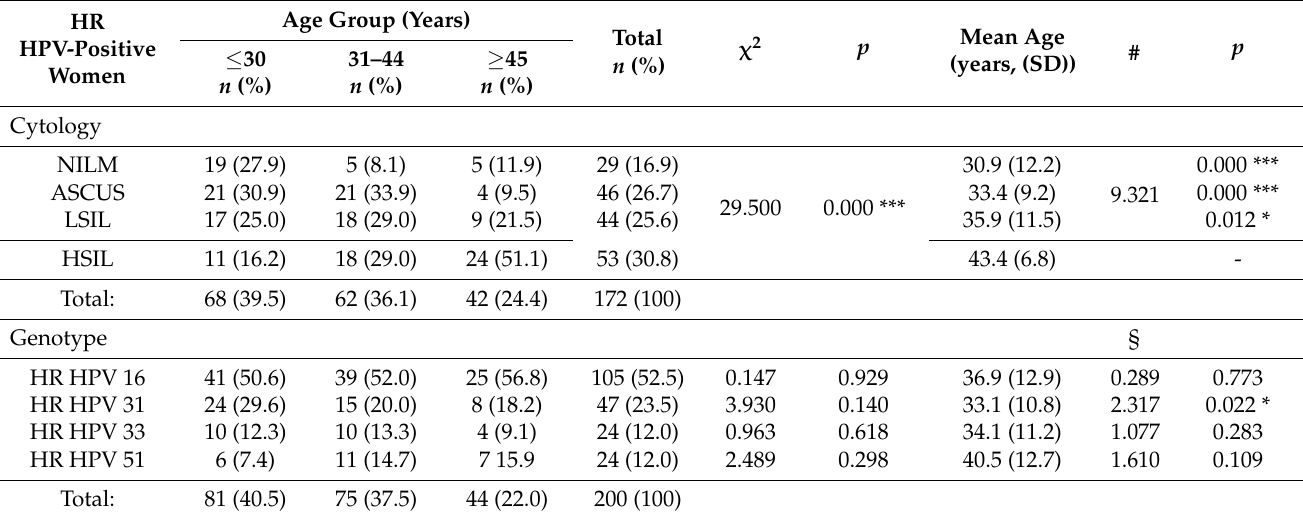
Table 5. Age-specific distribution of female patients with different cytological groups and